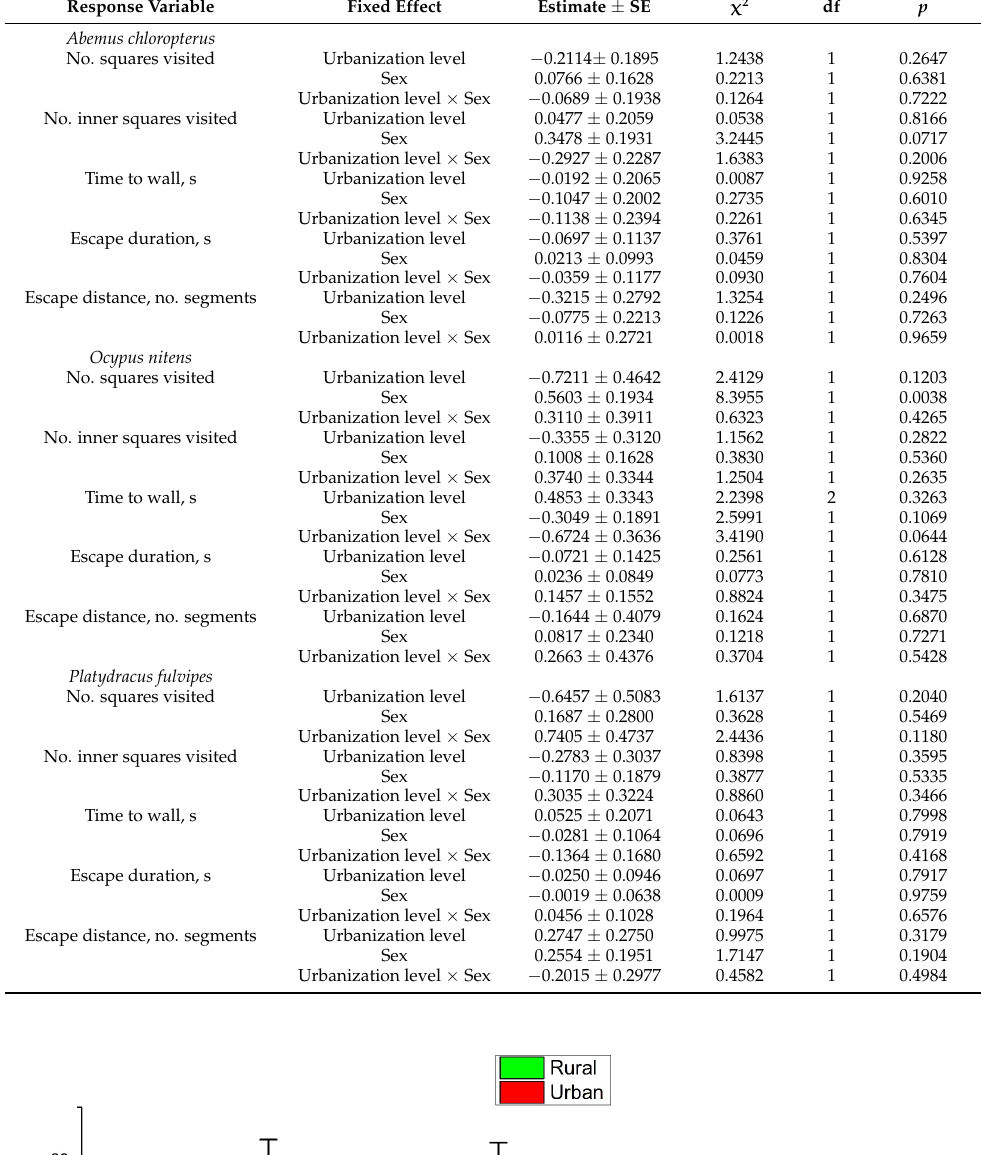
Table 3. Summary of GLMM results and post hoc tests on behavioral measures of the three studied rove beetle species in differently urbanized (non-urbanized vs. urbanized) forested habitats ( p -values in bold denote significant effects).